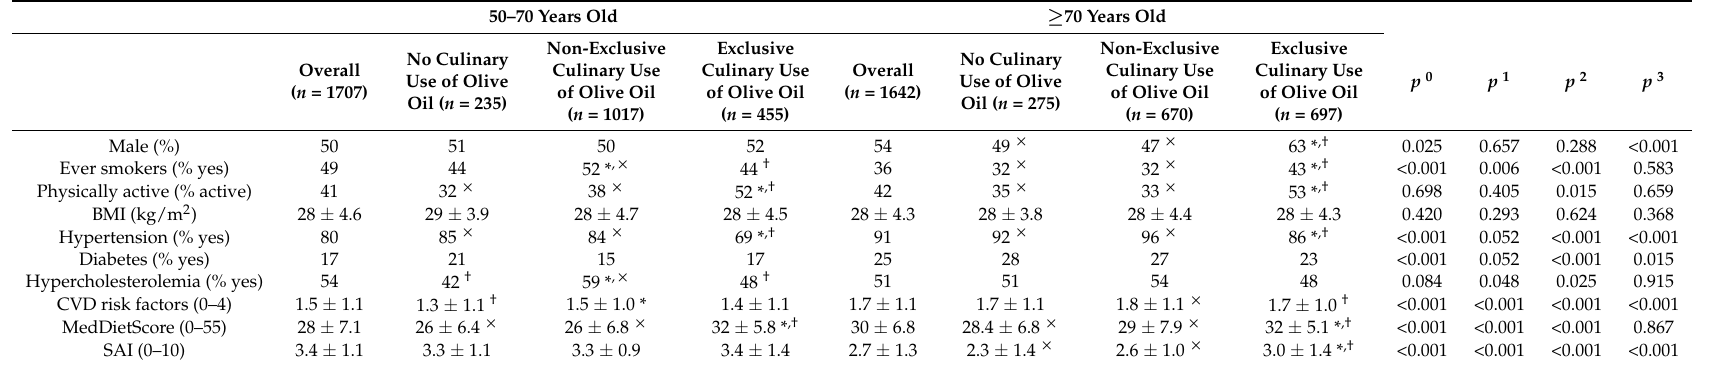
Table 2. Clinical and lifestyle characteristics of the participants, by age and type of culinary